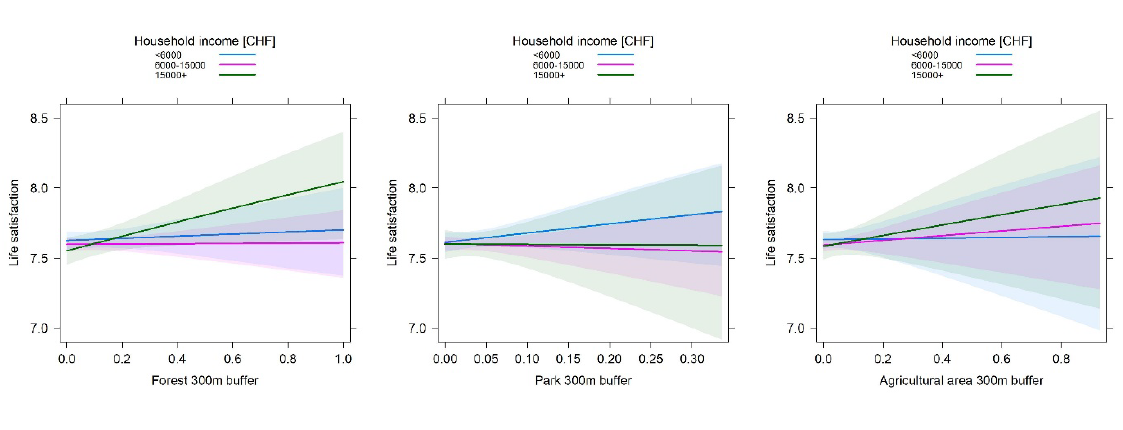
Figure S4 . Mutually adjusted greenspace associations with life satisfaction by household income, adjusted for life satisfaction in the past, age categories, sex, financial worries, canton, degree of urbanisation, and month of entry